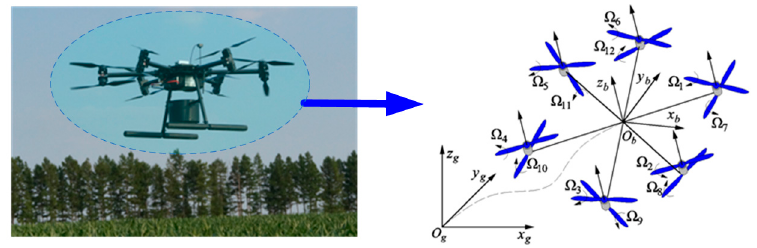
Figure 1. Structural sketch of a multi-rotor aircraft.